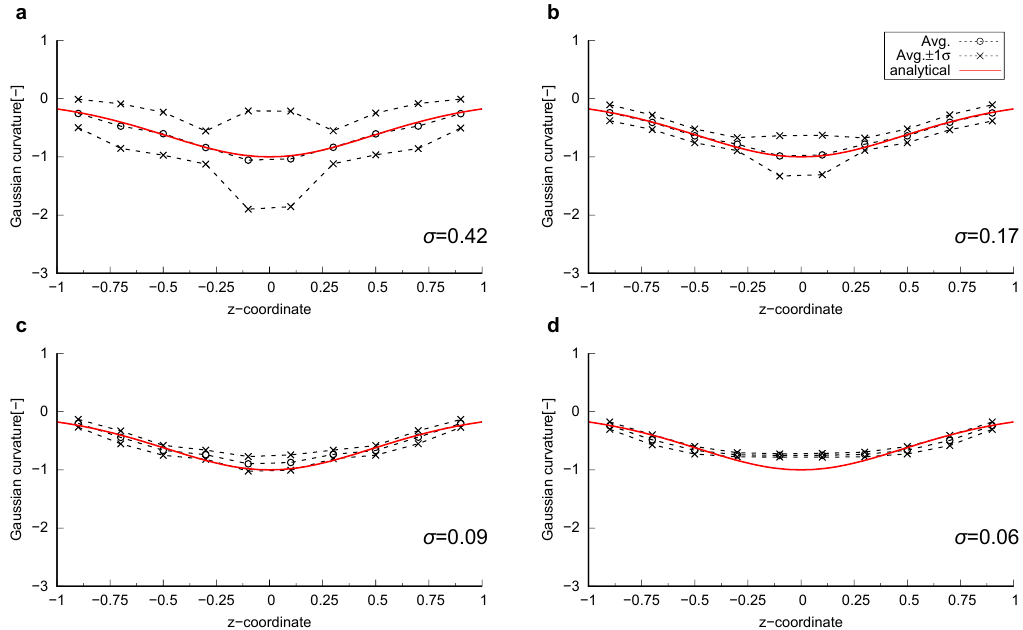
Figure 5. The computed Gaussian curvatures together with the values plus and minus one standard deviation ( σ ) on the smoothed surfaces of the catenoid compared to the analytical value as a function of the z -coordinate. The Gaussian curvature of the catenoid for ( a ) ∆ = 0.025, ( b ) ∆ = 0.05, ( c ) ∆ = 0.1 and ( d ) ∆ =